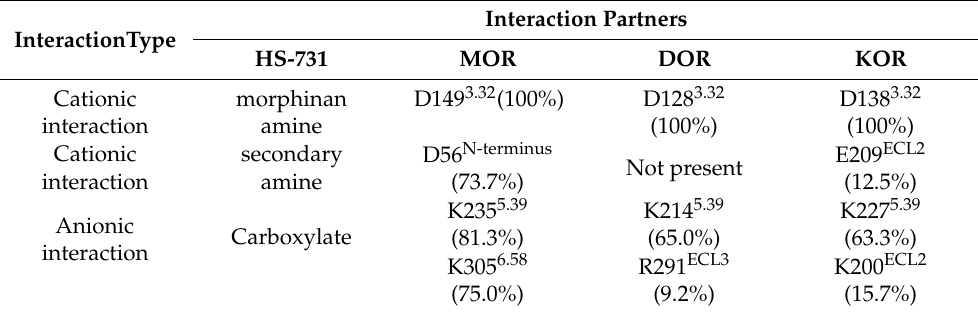
Table 2. Ionic interaction occurrence between HS-731 and the three classical opioid receptors during MD